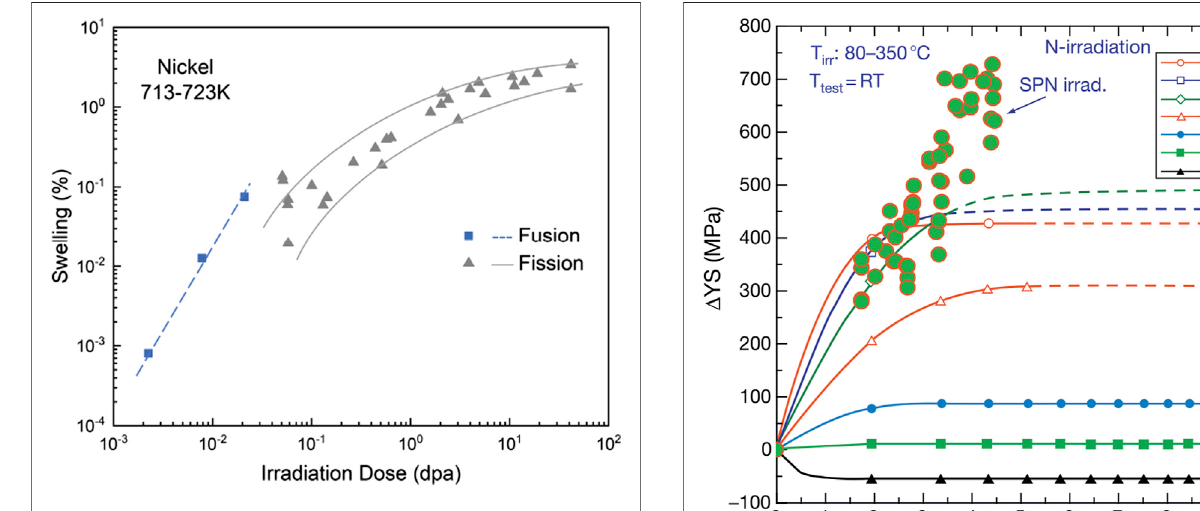
FIGURE 1 | Variation of cavity swelling with dose in nickel irradiated with fi ssion and fusion neutrons. The swelling after low-dose fusion neutron irradiation is much greater than that after fi ssion neutron irradiation. Reproduced with permission from Singh and Zinkle (1993). Copyright 1993 Elsevier.